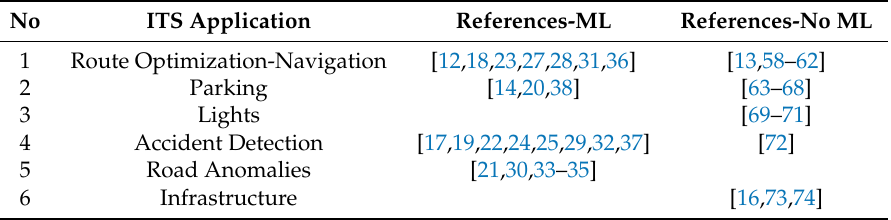
Table 2. References to IoT smart transportation